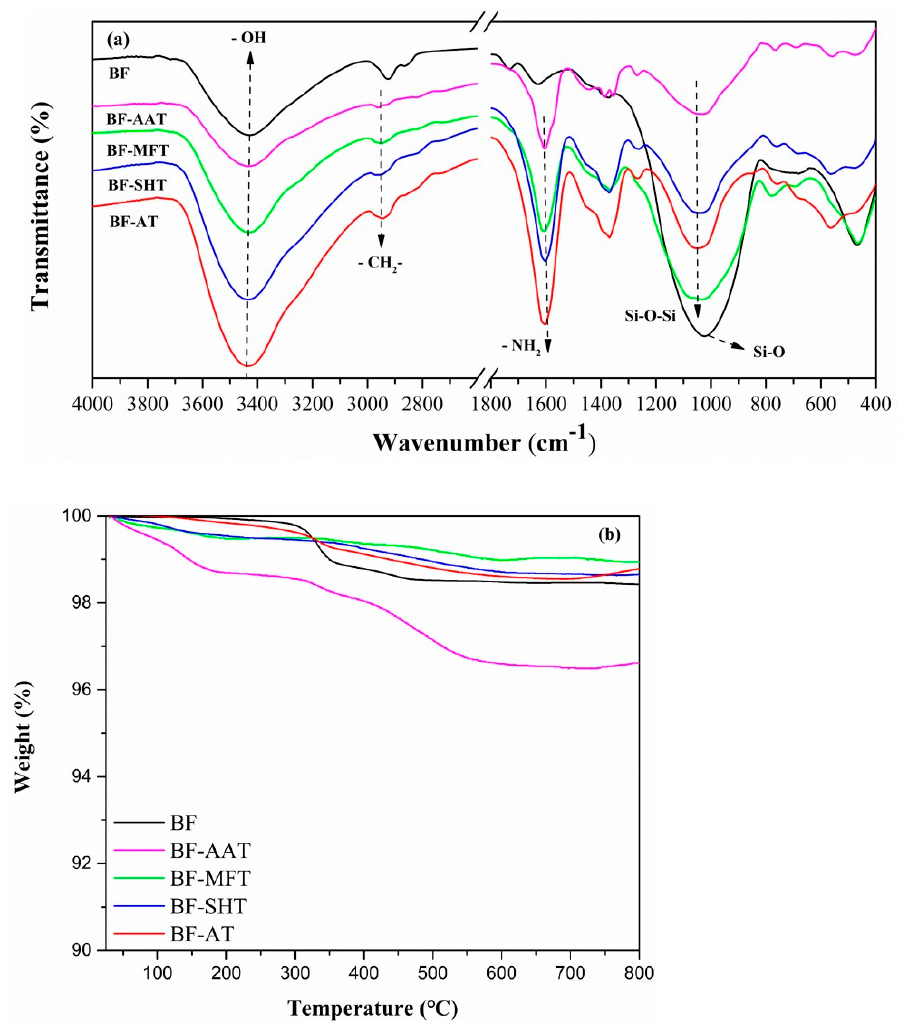
Figure 2. ( a ) FTIR spectra of BF and modified BF; ( b ) thermogravimetric analysis (TGA) of BF and modified BFs.